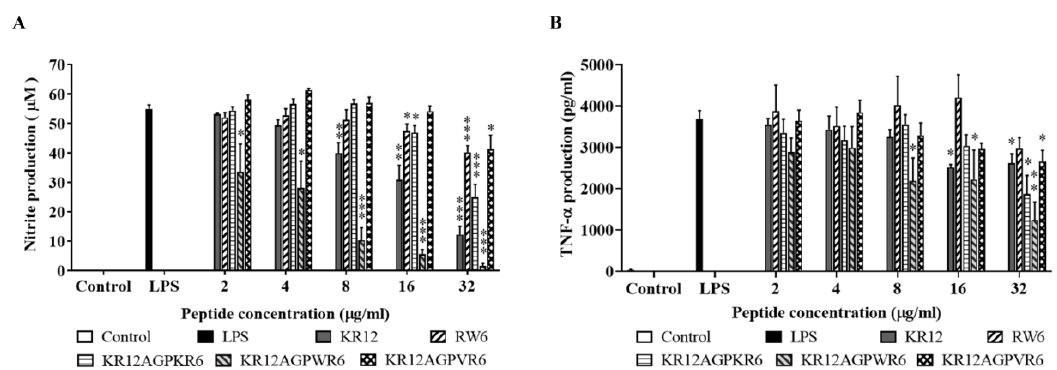
Figure 5. Inhibition of ( A ) LPS-induced nitric oxide (NO) production and ( B ) TNF-α release by the designed peptides with 2–32 μ-/mL working concentration in murine macrophage J774A.1 cells.